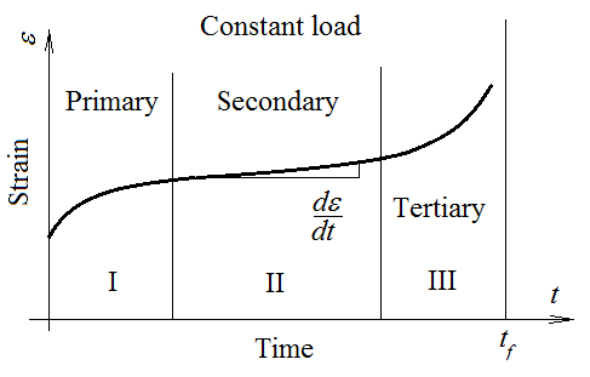
Figure 1. Usual creep behavior of a material (adapted from [2]).